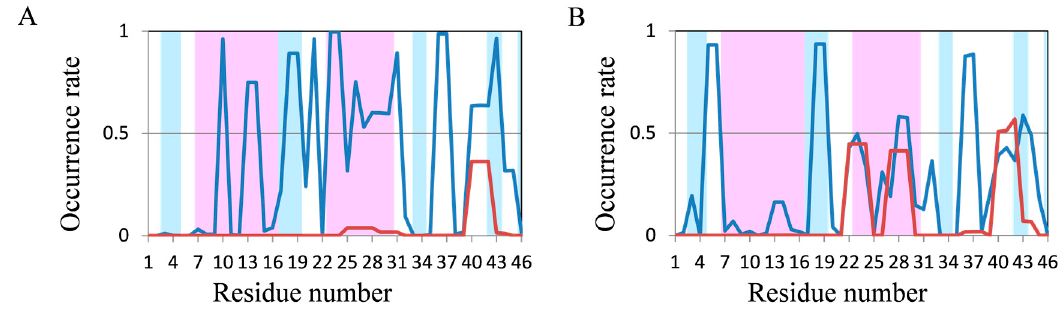
Figure 6. Analysis of the secondary structure formation in crambin (46 residues) using normal MD simulations. The occurrence rate of secondary structures of crambin using 200-ns simulations ( A ) and 2000-ns simulations ( B ). Color coding is the same as that in Figure 3.